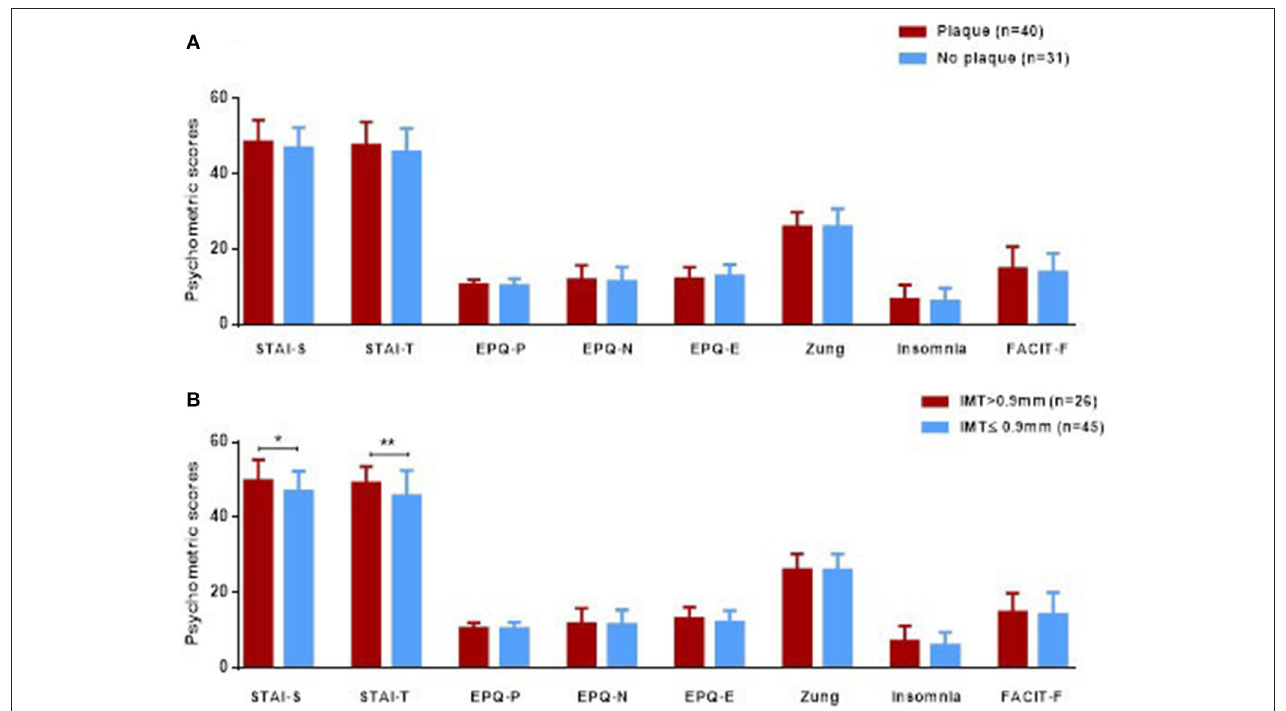
FIGURE 1 | Psychometric scores (expressed in mean ± SD) in 71 SLE patients with and without plaque formation (A) and arterial wall thickening (B) , defined as IMT scores > 0.90mm).Only statistical significant differences are displayed, * p < 0.05, ** p < 0.01. IMT, intima-media thickness; STAI, State-Trait Anxiety Inventory; EPQ, Eysenck Personality Questionnaire Scale; Zung, Zung Depression Scale; Insomnia, Athens Insomnia Scale; FACIT-F, Functional Assessment of Chronic Illness Therapy–Fatigue